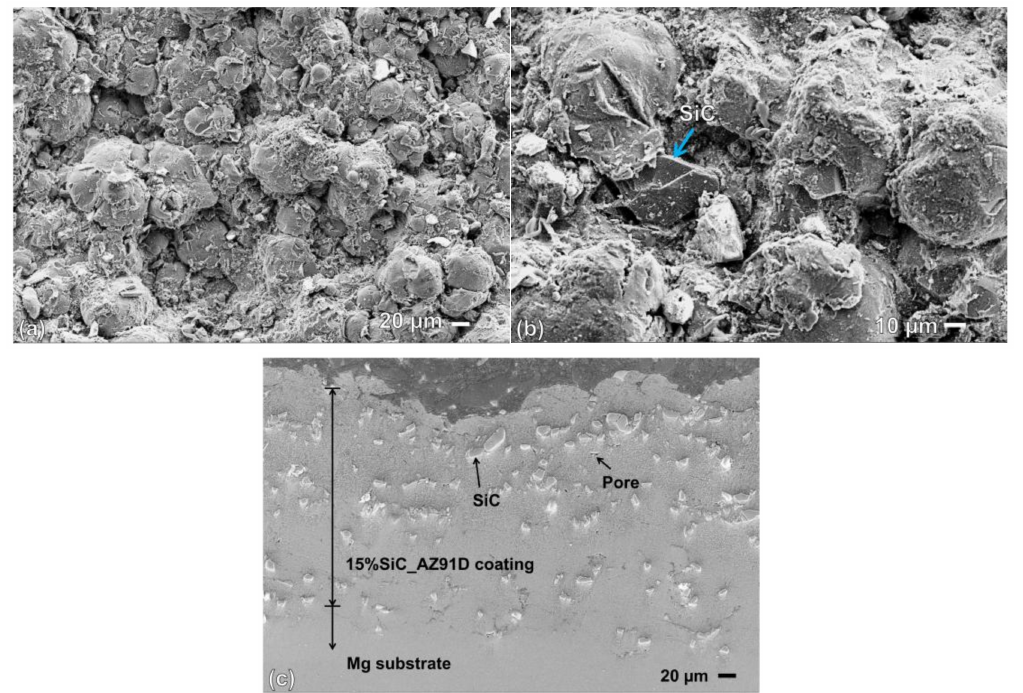
Figure 8. Top surface morphology the AZ91D coating ( a ), and SiC/AZ91D composite coating ( b ); and the cross–sectional microstructure SiC/AZ91D composite coating ( c